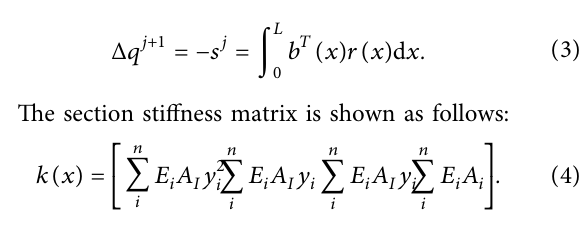
Figure 1: Schematic diagram of fber beam element